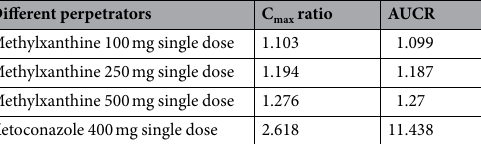
Table 3. C max ratio and AUCR (AUC ratio) changes when midazolam (7.5 mg/single dose) is used simultaneously with different doses of Methylxanthine (100, 250 and 500 mg) and Ketoconazole (200